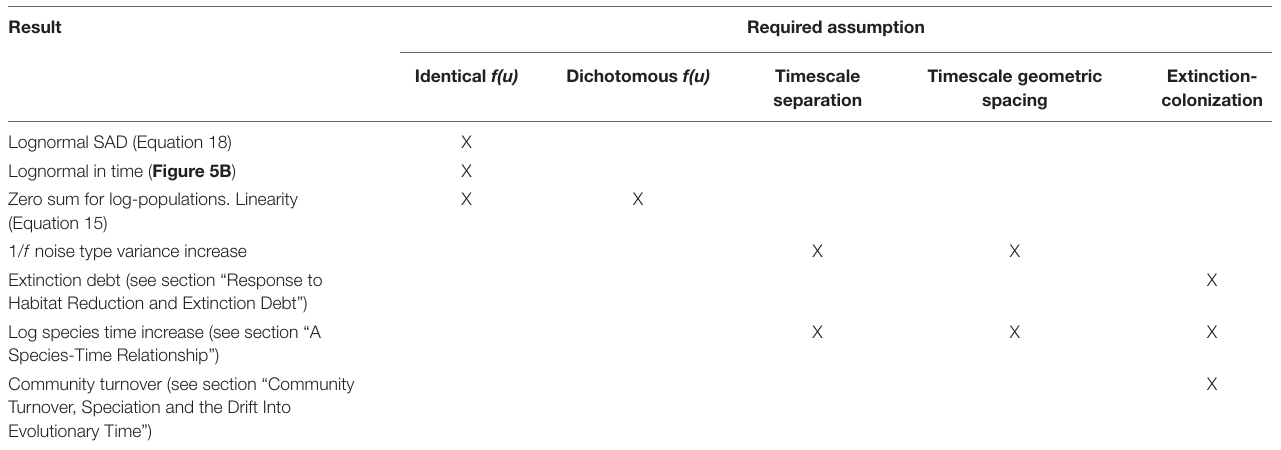
FIGURE 11 | (A) Species abundance distribution for a single community in one run of four different models taken at time t = 511 in each case. The models were: Special case A, Special Case B with B = 1.15, Special Case B with B = 1.73 and Special Case C with q = 0.2 and B = 1.73. (B) For the same four models, the histogram of population size over time for a run covering 512 years for species number 126 in each case. The other parameters of the models were J = 10 5 , K = 7, and MVP = 2. The dynamics are according to Equation (10) without extinction-colonization. TABLE 2 | The main additional assumptions required to produce the results in this